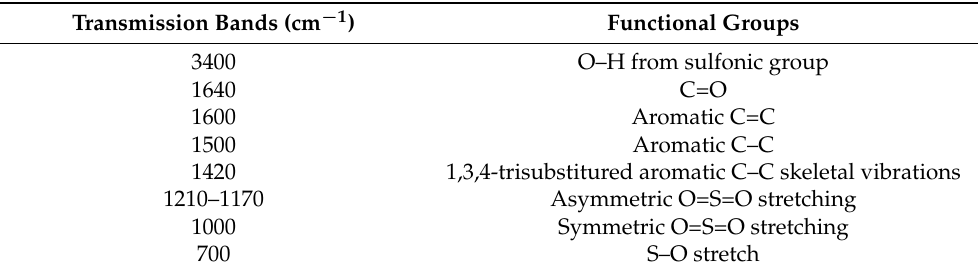
Table 2. Transmission bands of casted SPEEK/cloisite and SP/e-spunCL membranes.